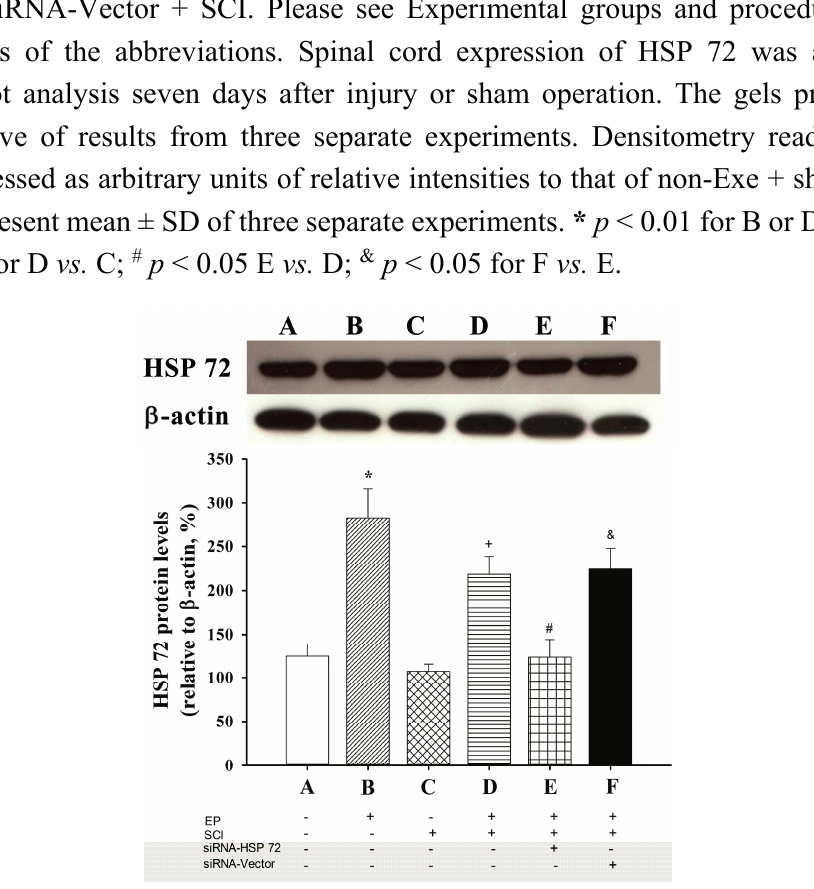
Figure 1. Effect of exercise on spinal cord expression of HSP 72 in different groups of